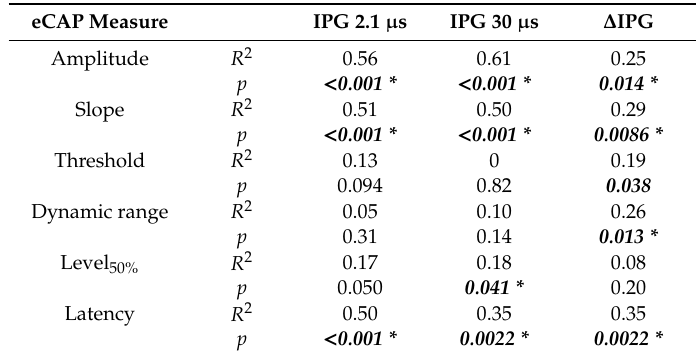
Table 2. R 2 and p values from correlations between single-pulse eCAP characteristics and basal SGC survival in 6WD